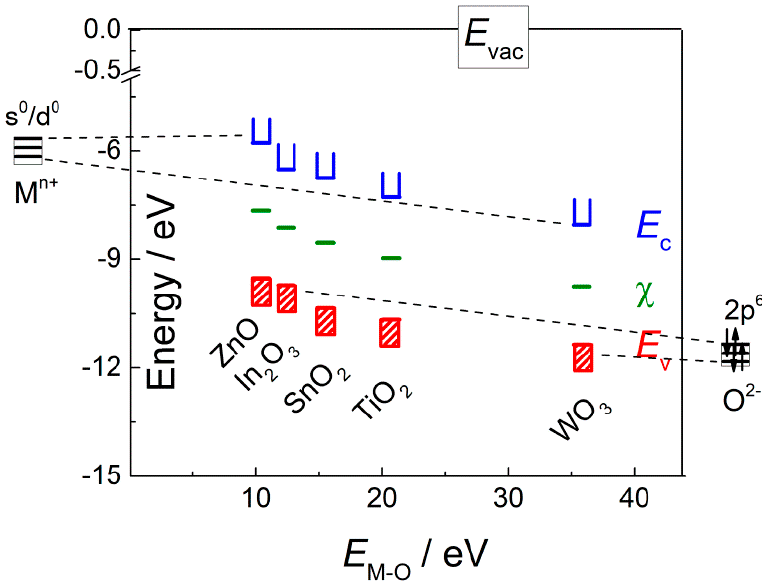
Figure 4. Positions of conduction band minima ( E c ), valence band maxima ( E v ) and electronegativity ( χ ) of n -type MOS, respective to vacuum level ( E vac ). Adapted with permission using numeric data from ref. [54]. Copyright 2011 Elsevier. The oxides electronegativity corresponds to middle bandgap position. The levels of atomic orbitals for metal cations (M n+ s 0 /d 0 ) and oxygen anions (O 2 − 2p 6 ) are shown schematically.